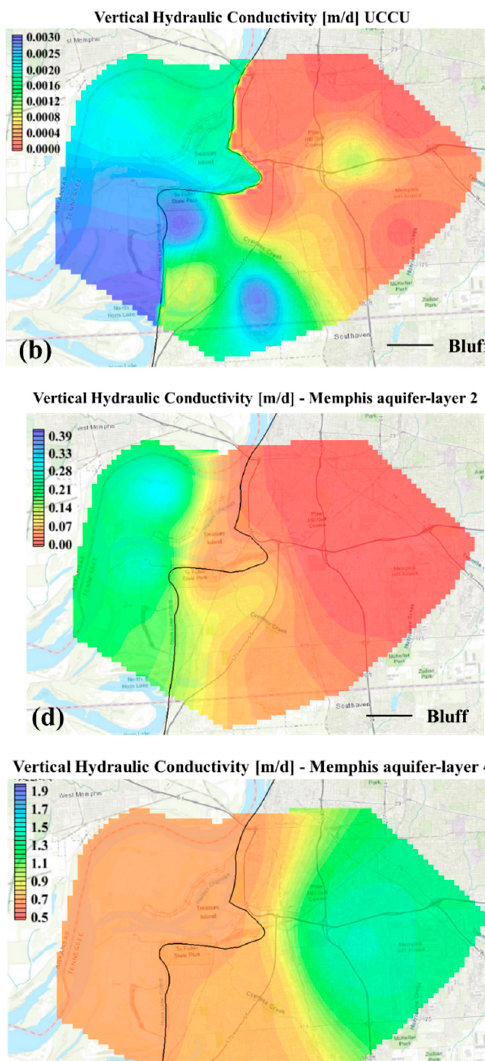
Figure A1. ( a – f ) The horizontal hydraulic conductivities of each numerical layer.